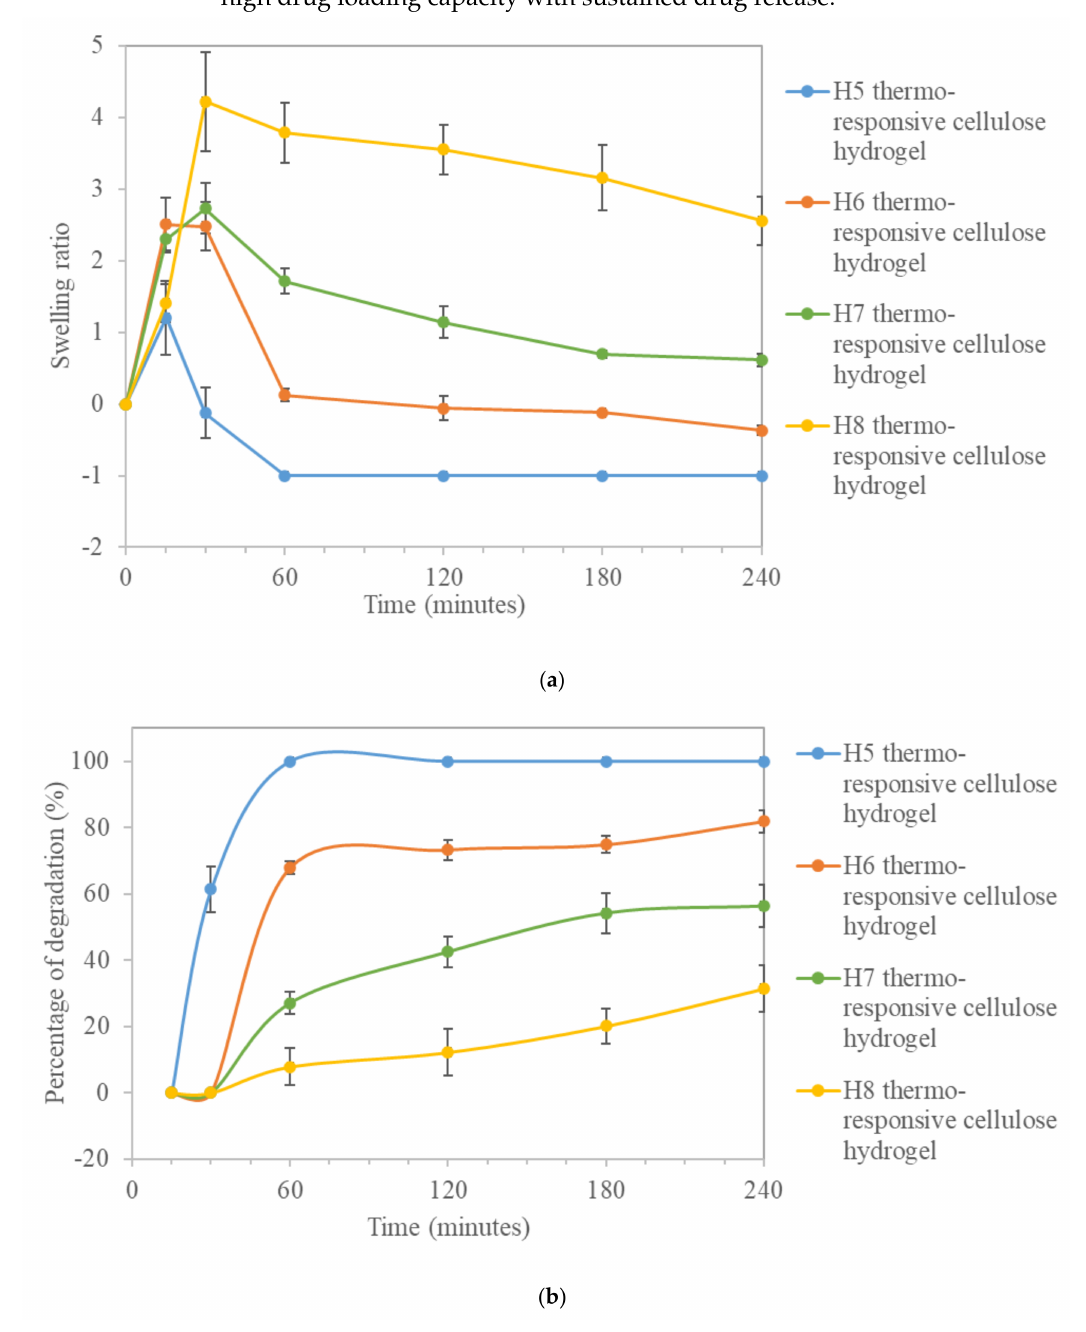
Figure 5. ( a ) Swelling ratio and ( b ) percentage degradation of thermo-responsive cellulose